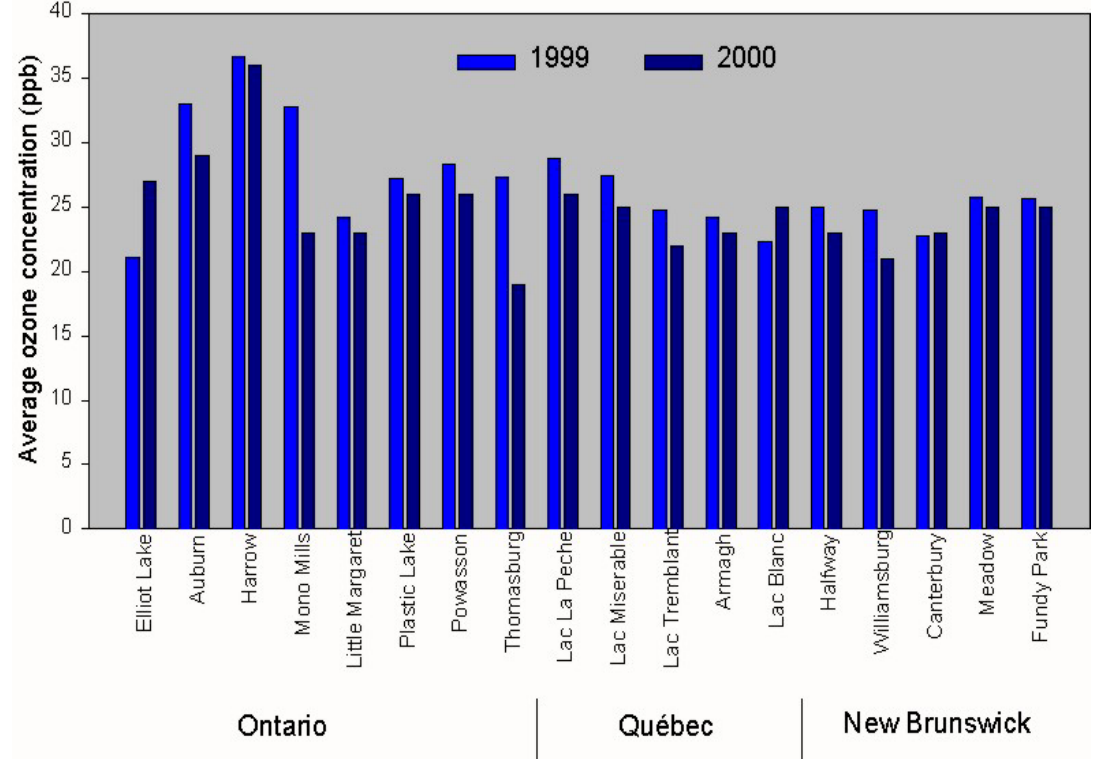
FIGURE 10. Ozone exposure values from CanOxy Plate passive samplers placed in the canopy of forest plots in the transect of the Forest Indicators of Global Change (FIGC) project of the Canadian Forest Service–Forest Health